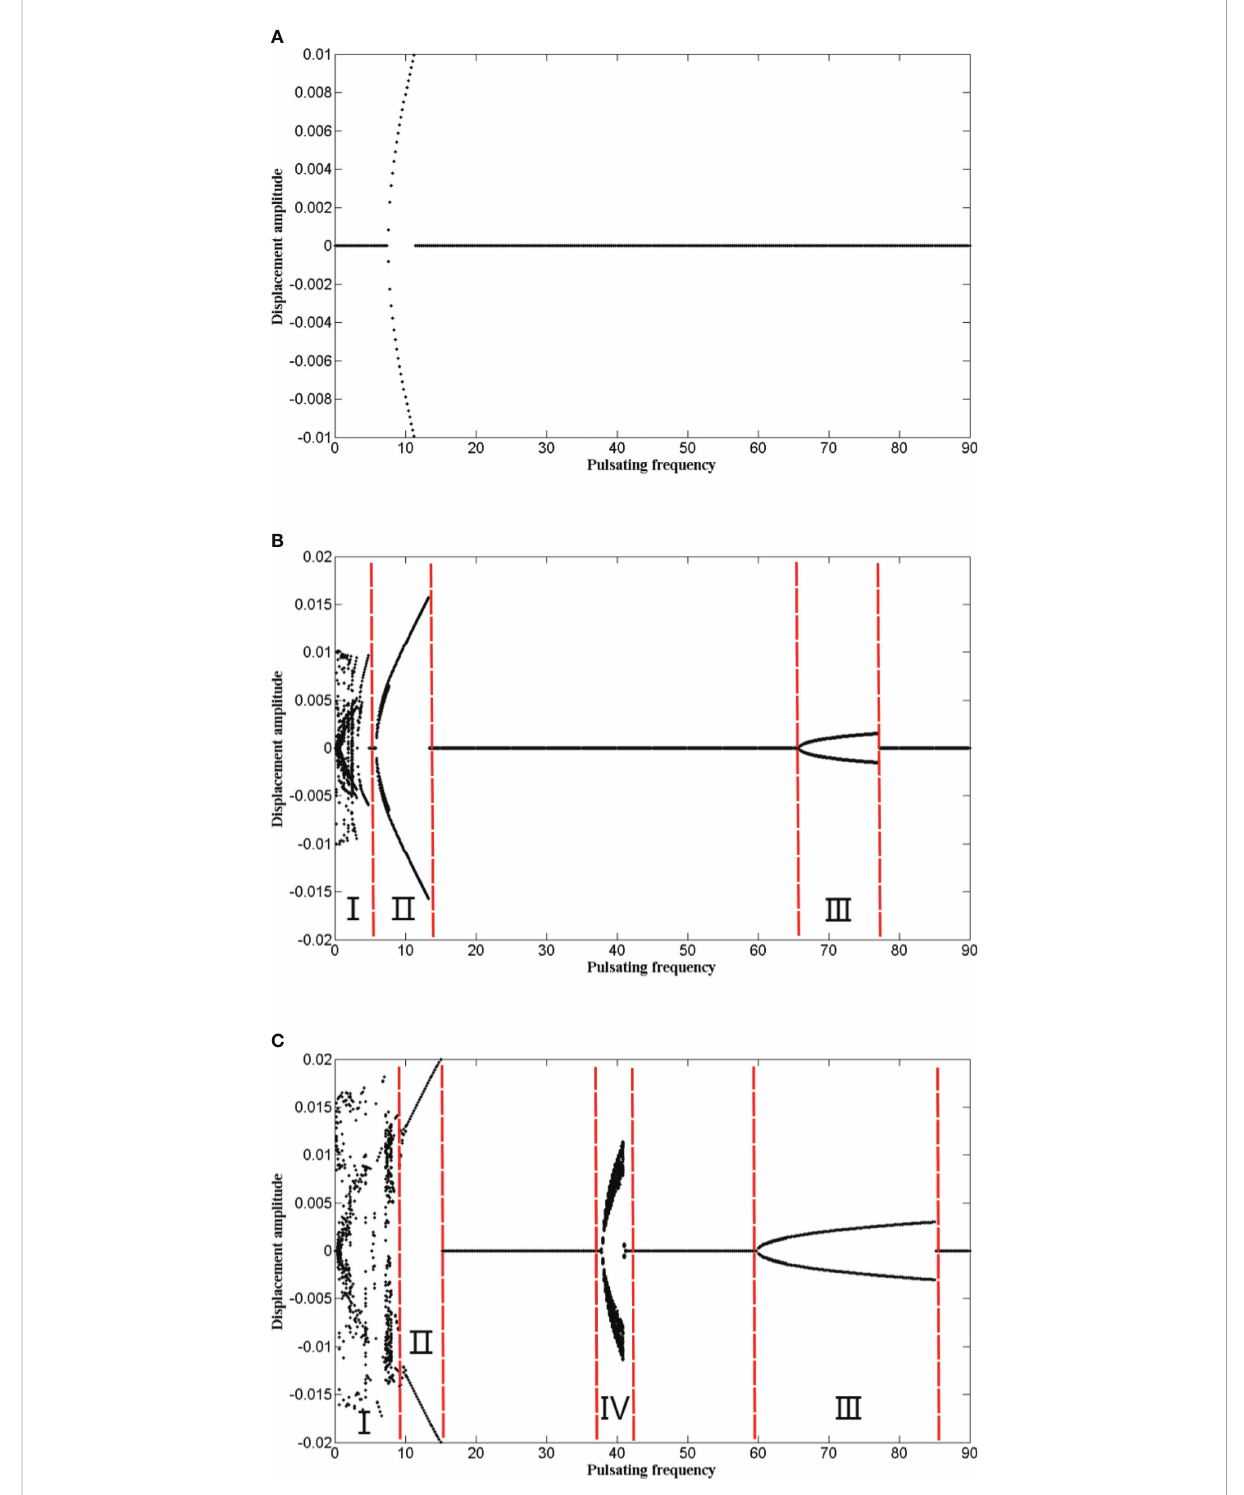
FIGURE 12 The bifurcation diagrams for the midpoint of the pipe with different pulsating amplitudes (in which u = 2, υ = 2, and the control parameter is the pulsating frequency w p ). (A) m = 0.2; (B) m = 0.4; (C) m =